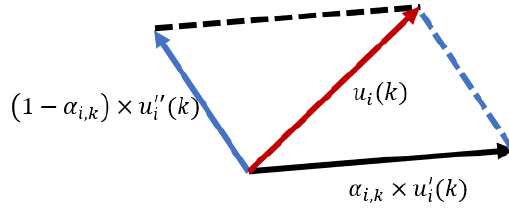
Figure 2. The composition of the control input. Combined with Algorithm 1, the optimal RL-based coverage placement algorithm is summarized in Algorithm